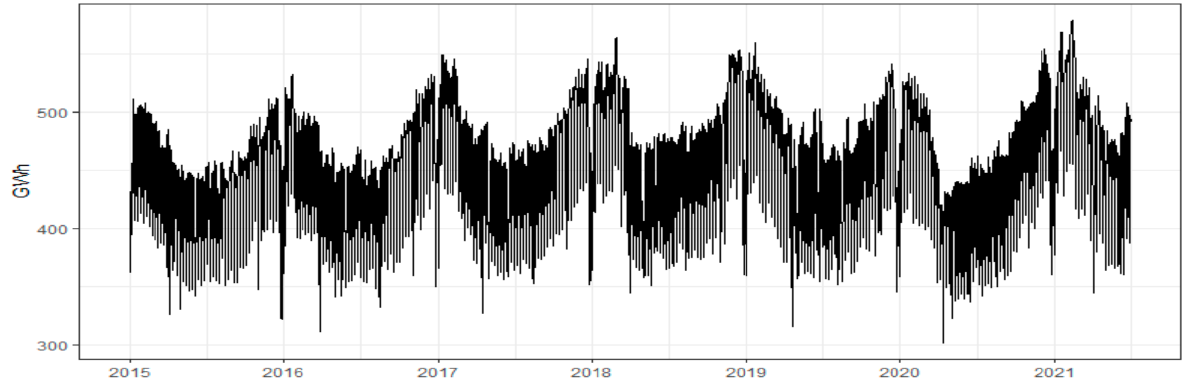
Figure 7. Daily energy consumption in Poland from 31 December 2014 to 30 June 2021 (in GWh). Two time points with missing data were observed in the set. To complete the series, an imputation method was used based on linear interpolation for data with